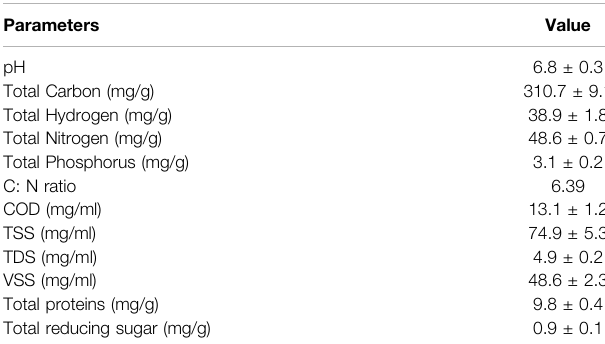
TABLE 2 | Characterization of biosolids